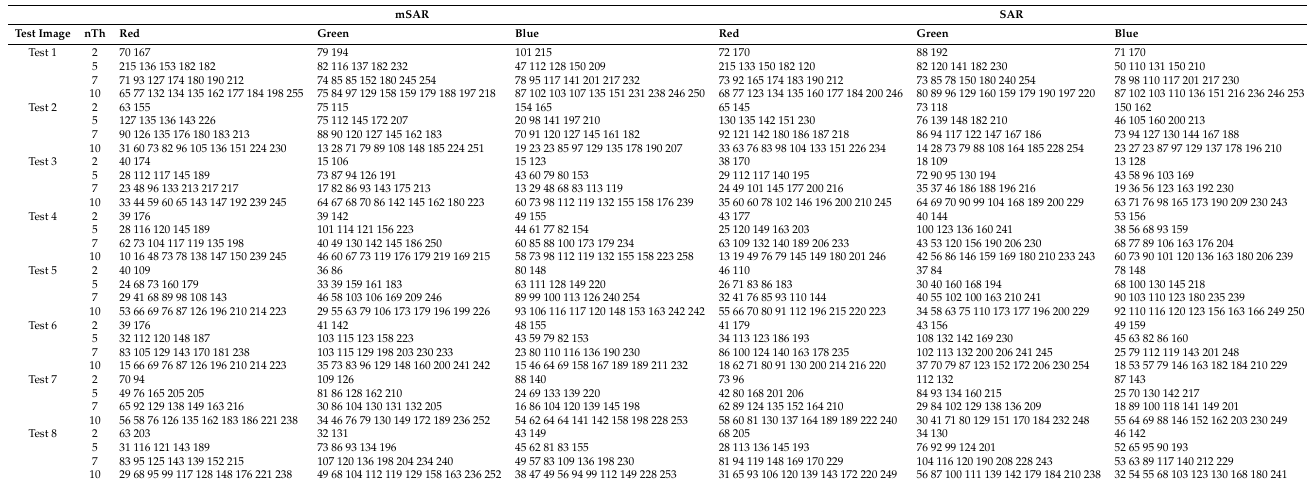
Table A3. The optimal threshold values are obtained by the Otsu method.